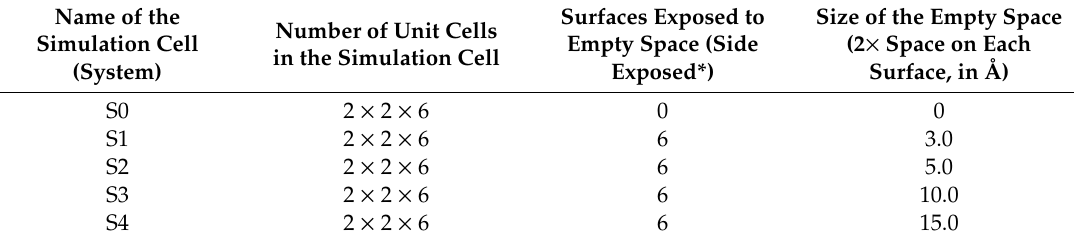
Figure 1. ( a ) Simulation cell in the system S4 in the X-Y plane. Simulation cell boundary is marked by the black border lines, while the borders of the supercell made by replicating a unit cell of Mg-MOF-74 2 × 2 × 6 times along the cell vectors a and b are marked by red and green lines, respectively. The colored lines thus enclose a crystallite while the space between the black and colored lines is the inter-crystalline space. Some CO 2 molecules adsorbed within the crystallite as well as in the inter-crystalline space can be seen. ( b ) The simulation cell in the S4 system in the X-Z plane. As in ( a ) colored and black lines mark the boundaries of the crystallite and the simulation cell, respectively. ( c ) A rendering of the simulation cell in S4 in the X-Y plane with periodic boundary conditions applied. Crystallites separated by inter-crystalline space can be seen. The red arrows indicate that the system is repeated in all directions infinitely. Table 1. Summary of simulation cells used in the study.